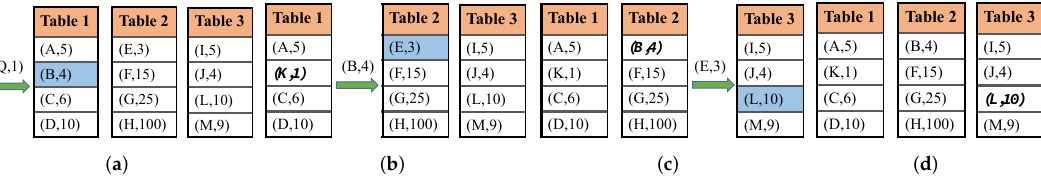
Figure 6. An illustration of HashPipe in KVSwitch. ( a ) Initial state; ( b ) New key is placed with value 1 in first stage; ( c ) B being larger the E; ( d ) L is retained in